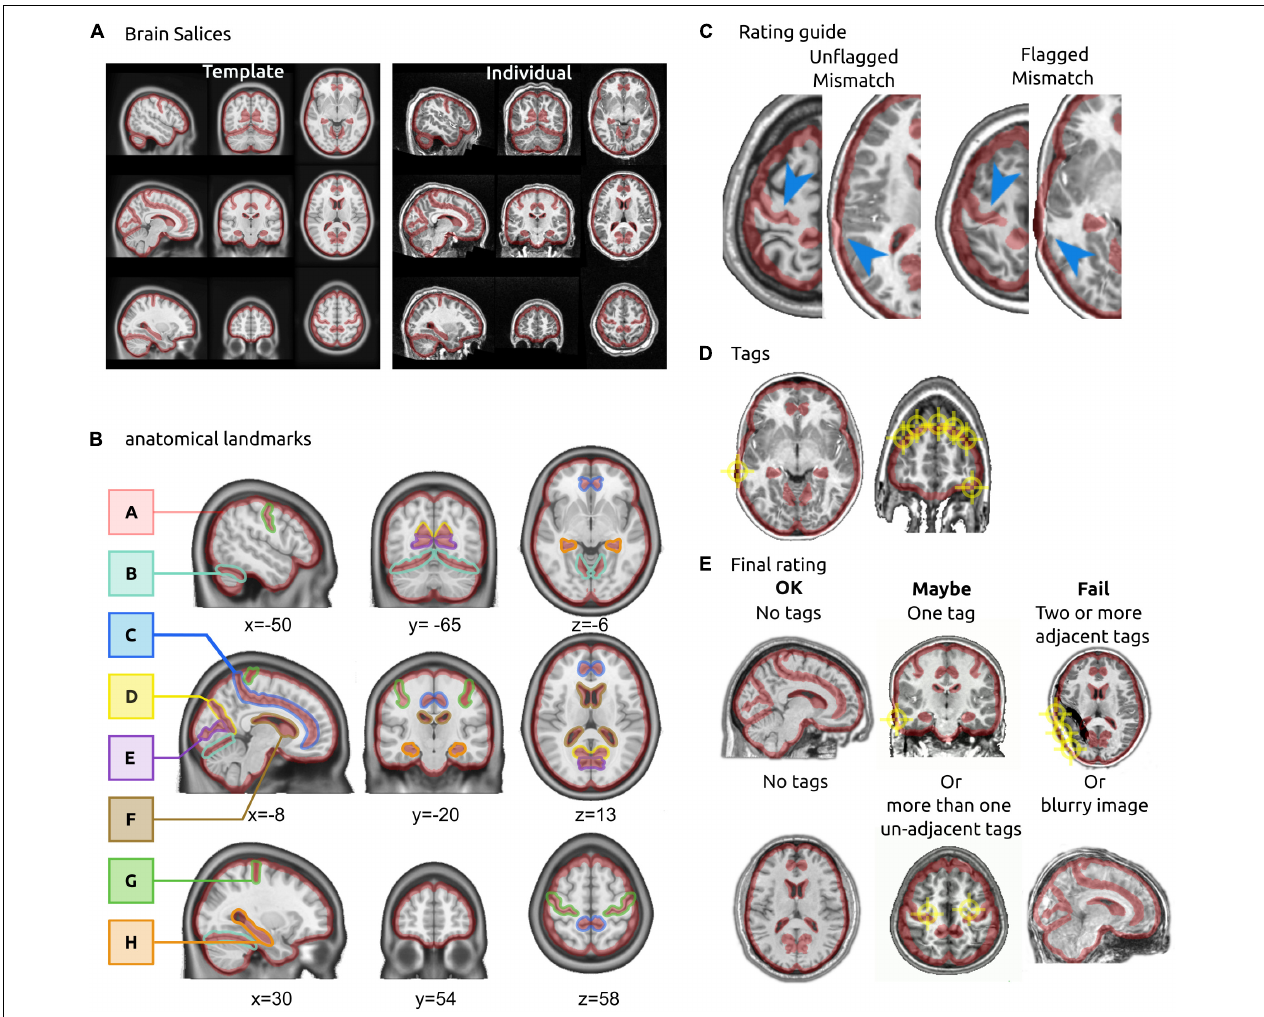
FIGURE 1 | QC protocol for brain registration. (A) Brain slices. The rater is presented with two sets of brain slices (3 axial, 3 sagittal and 3 coronal), one of them showing the template in stereotactic space and the other showing an individual T1 brain after registration. In the interface, the two images are superimposed and the rater can flip between them to visually assess the registration. (B) Anatomical landmarks. The landmarks for QC included: the outline of the brain (A), tentorium cerebelli (B), cingulate sulcus (C), parieto-cingulate sulcus occipital fissure (D), calcarine fissure (E), the lateral ventricles (F), central sulcus (G) and the hippocampal formation (H) bilaterally. The landmarks were outlined in stereotaxic space. (C) Rating guidelines. The boundaries of red landmarks act as “confidence interval” for registration: an area is tagged as a misregistration only if the target structure falls outside the boundaries. (D) Tags. Raters put tags on each misregistered brain structure. (E) Final rating. A final decision is reached on the quality of registration: an image with no tags is rated OK, one or more non-adjacent tags are rated Maybe, two or more adjacent tags are rated Fail. An image that is excessively blurry is also rated